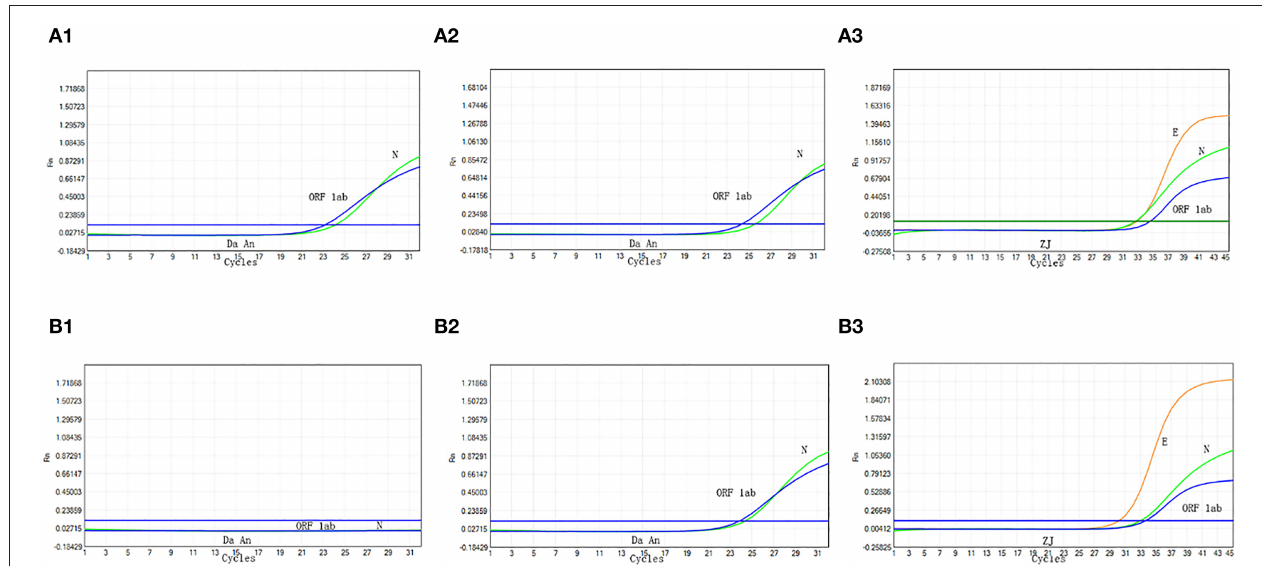
FIGURE 1 | Real-time reverse transcriptase polymerase chain reaction (RT-PCR) analysis of the original 10-pooled oropharyngeal swab sample. The sample is analyzed by RT-PCR with Da An Kit for the first time (A1) . The sample is re-extracted and analyzed by Da An Kit (A2) and ZJ Kit (A3) . The negative process control (B1) and positive control (B2,B3) are also analyzed with RT-PCR.